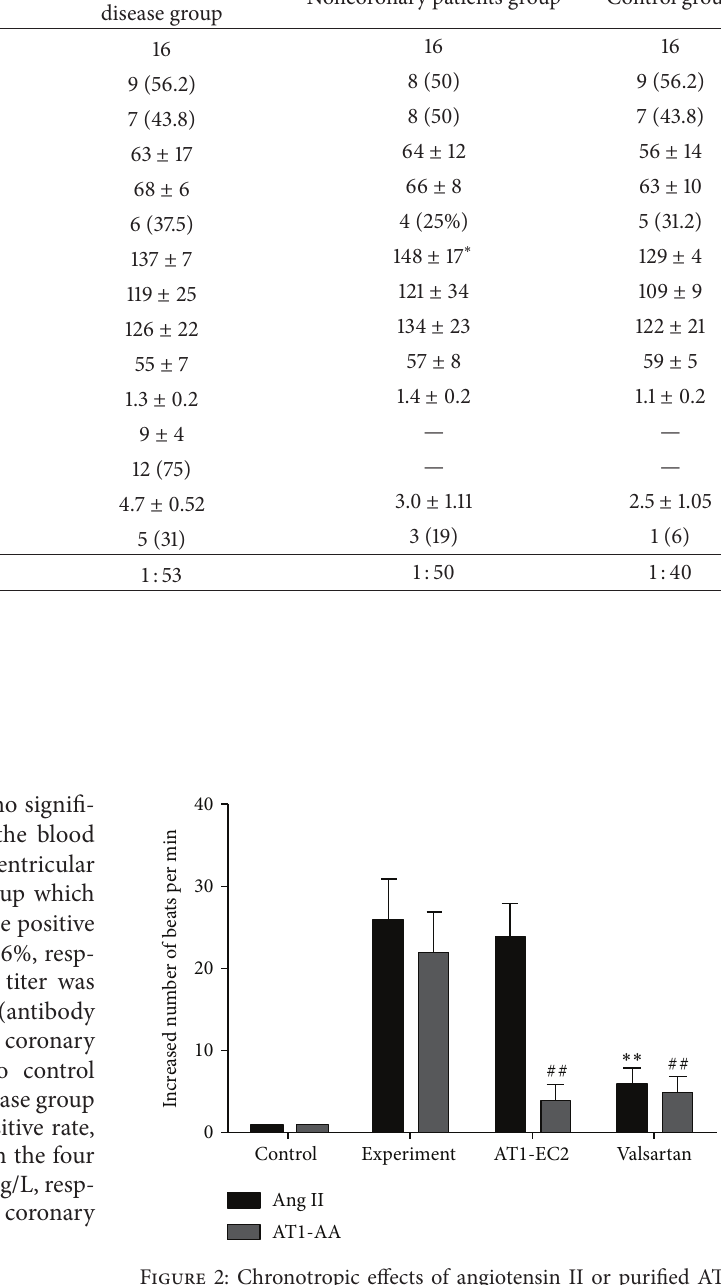
Figure 2: Chronotropic effects of angiotensin II or purified AT1- AAs from patients with acute coronary syndrome on cultured neonatal rat cardiomyocytes. Like angiotensin II (0.1 𝜇 M), AT1-AAs (20 𝜇 g/mL) increased cells beats about 22/min, and AT1 receptor blocker valsartan (1 𝜇 M) and overload AT1-EC2 peptide (1 𝜇 g/mL) could significantly inhibit this chronotropic effect demonstrating that AT1-AAs have an agonistic effect on the AT1 receptor. The nonspecific IgG (nsIgG) (20 𝜇 g/mL) was used as control; the beats were not increased as is shown. Ang II: angiotensin II, AT1-AAs: autoantibodies against the AT1 receptor; ∗∗ 𝑃 < 0.01 versus Ang II control group; ## 𝑃 < 0.01 versus AT1-AAs control group. The data were organized from 5 independent experiments each treated with one of the positive samples and repeated three